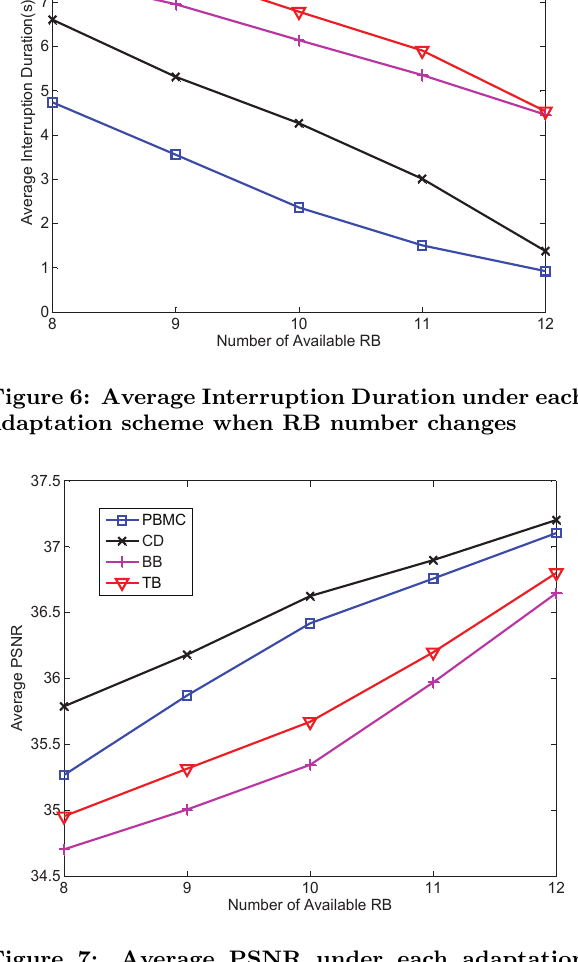
Figure 7: Average PSNR under each adaptation scheme when RB number